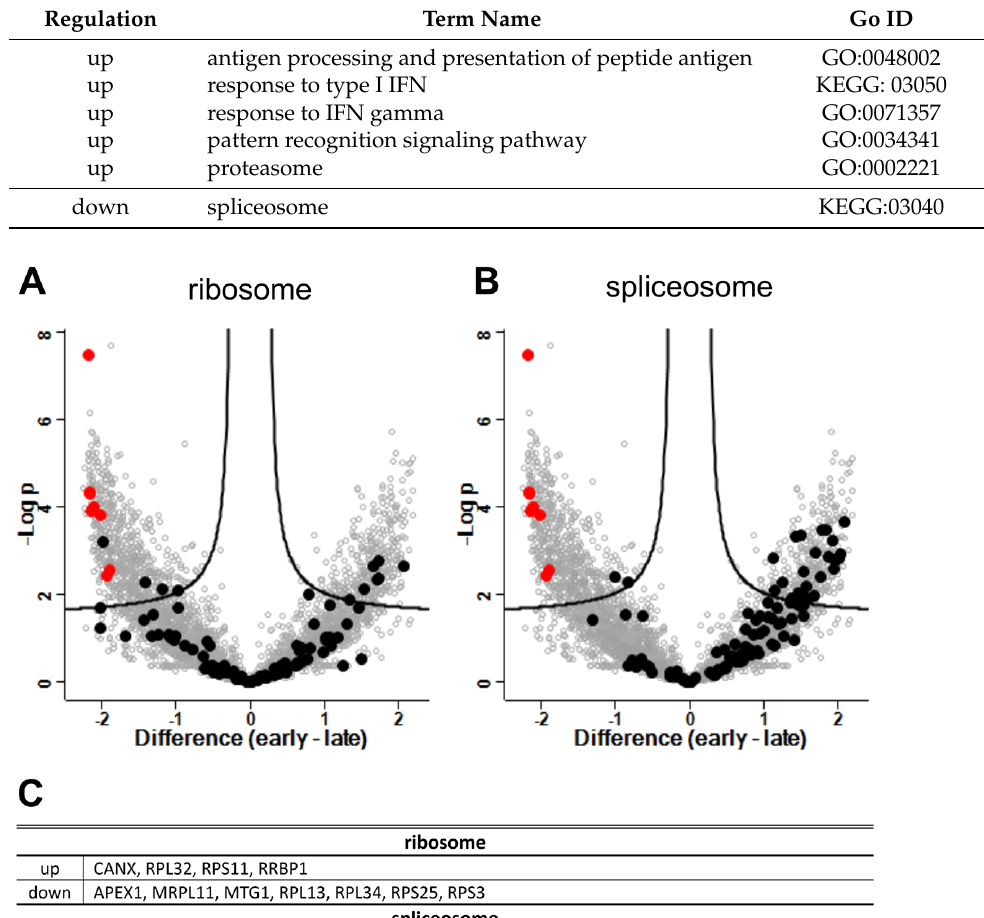
Table 1. Overview of selected GO/KEGG terms for a more detailed analysis, based on GO-term enrichment analysis of differentially regulated genes with the gProfiler software (Table S5).